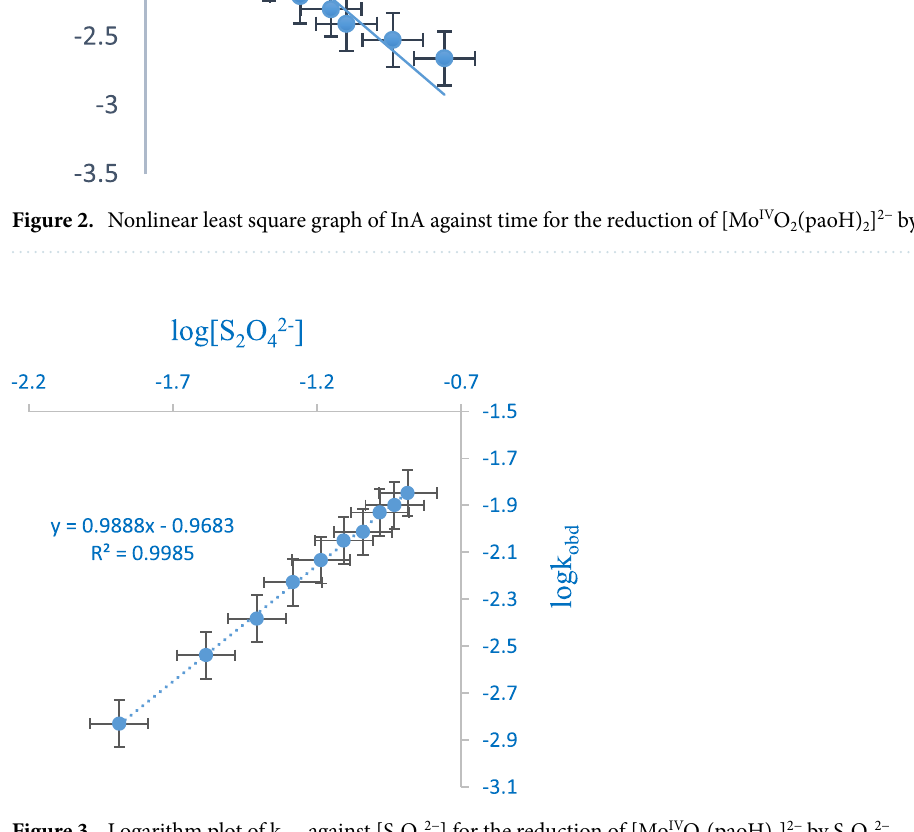
Figure 3. Logarithm plot of k obd against [S 2 O 42− ] for the reduction of [Mo IV O 2 (paoH) 2 ] 2− by S 2 O 42−